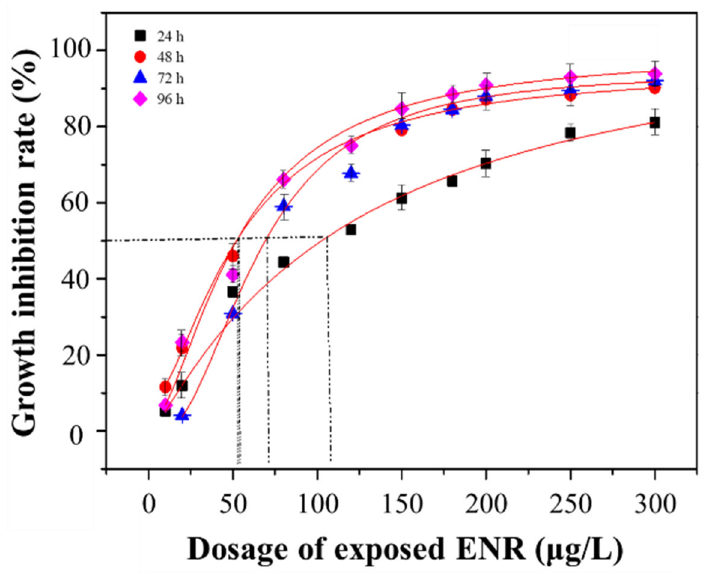
Figure 3. The growth inhibition rate of algae under different exposure dosages of ENR.